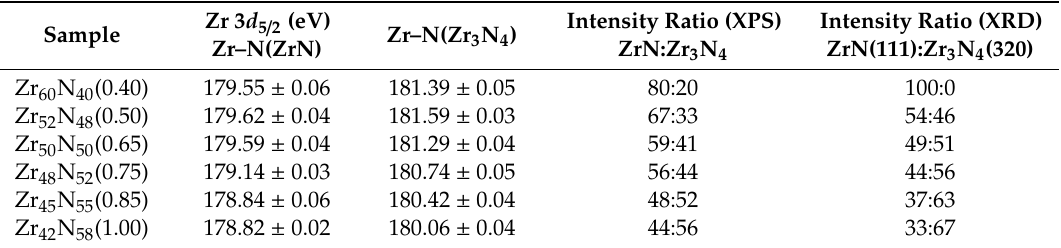
Figure 7. XPS profiles of the ( a ) Zr 3 d and ( b ) N 1 s core levels of the ZrN x films ( f = 0.50–1.00) at a sputter depth of 48 nm. Table 2. XPS binding energies and intensity ratios of XRD reflections of the ZrN x films.